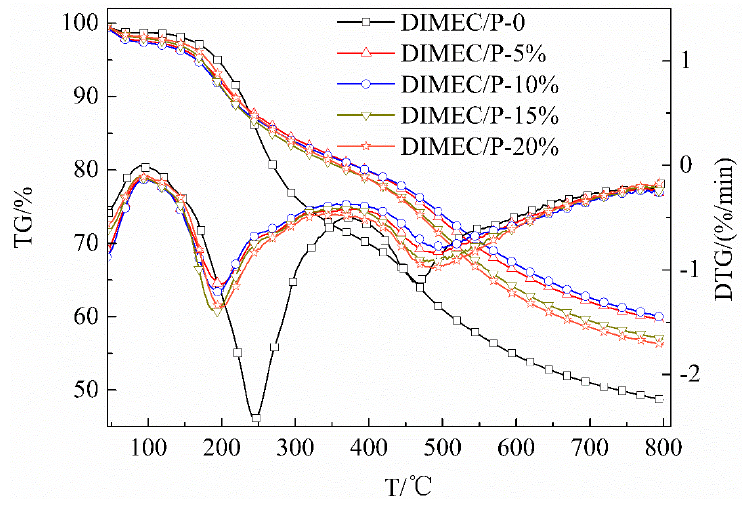
Figure 15. TG and DTG of CPFs.